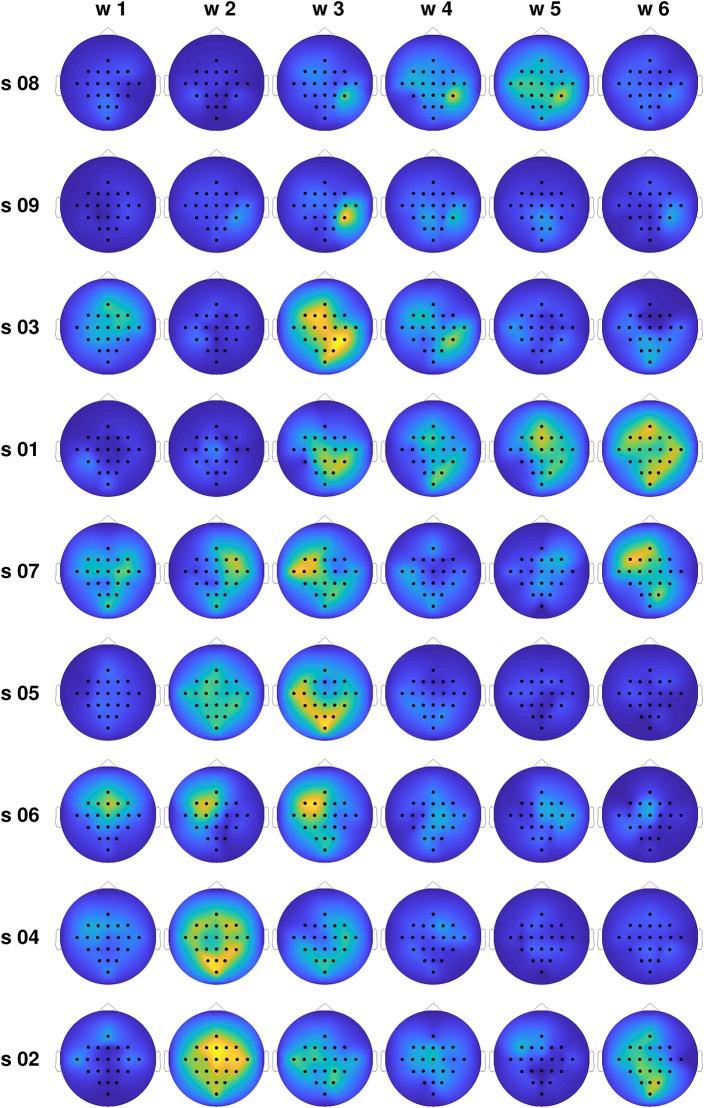
Normalized average differences in the total information flow coming into each channel for the training set, for all subjects and time windows. Large differences are coded in yellow, while small differences are presented in blue.